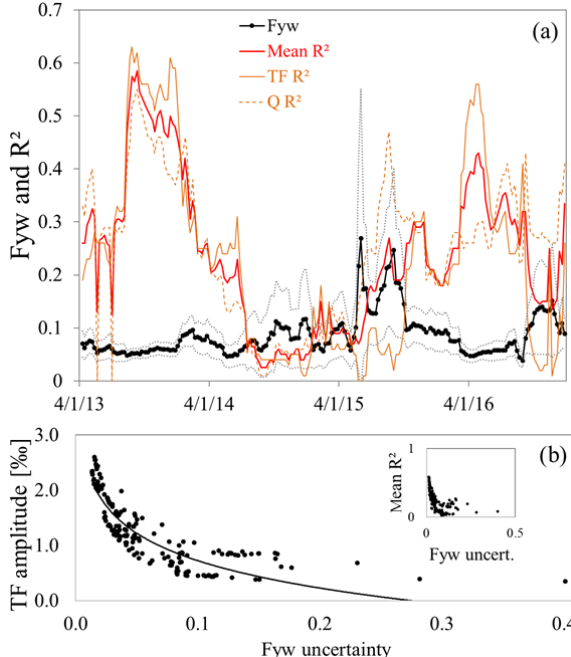
Figure 3. Sine waves (red lines) were fitted to (a) throughfall and (b) streamflow stable isotope data (grey line), with maximum and minimum values at each point in time (black enveloping curve). In comparison a single sine wave was fitted to the complete dataset for both throughfall and streamflow (green lines). The omitted precip- itation isotope values of the 2015 European summer heat wave are shown in panel (a) with bold black lines.